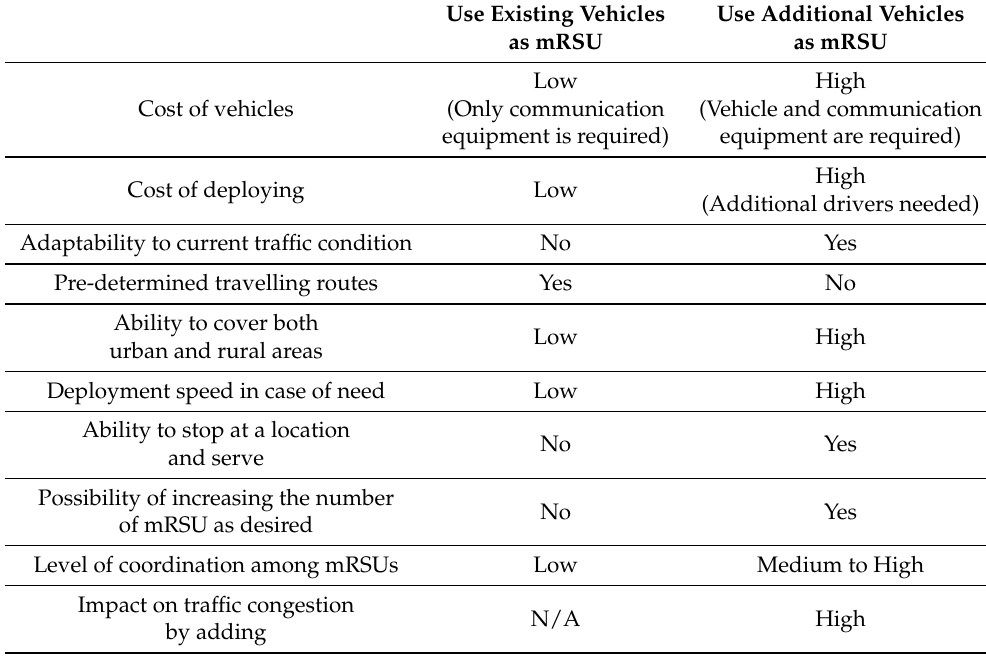
Table 1. Comparison of different mRSU